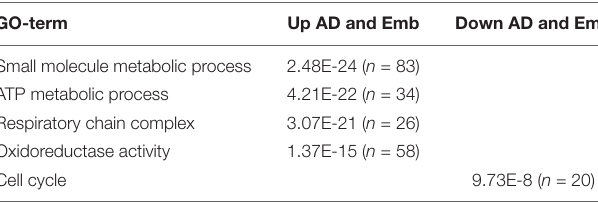
TABLE 3 | Main gene ontology terms enriched in genes up- or down-regulated in adult (AD) and embryonic (Emb) hemocytes as compared to larval